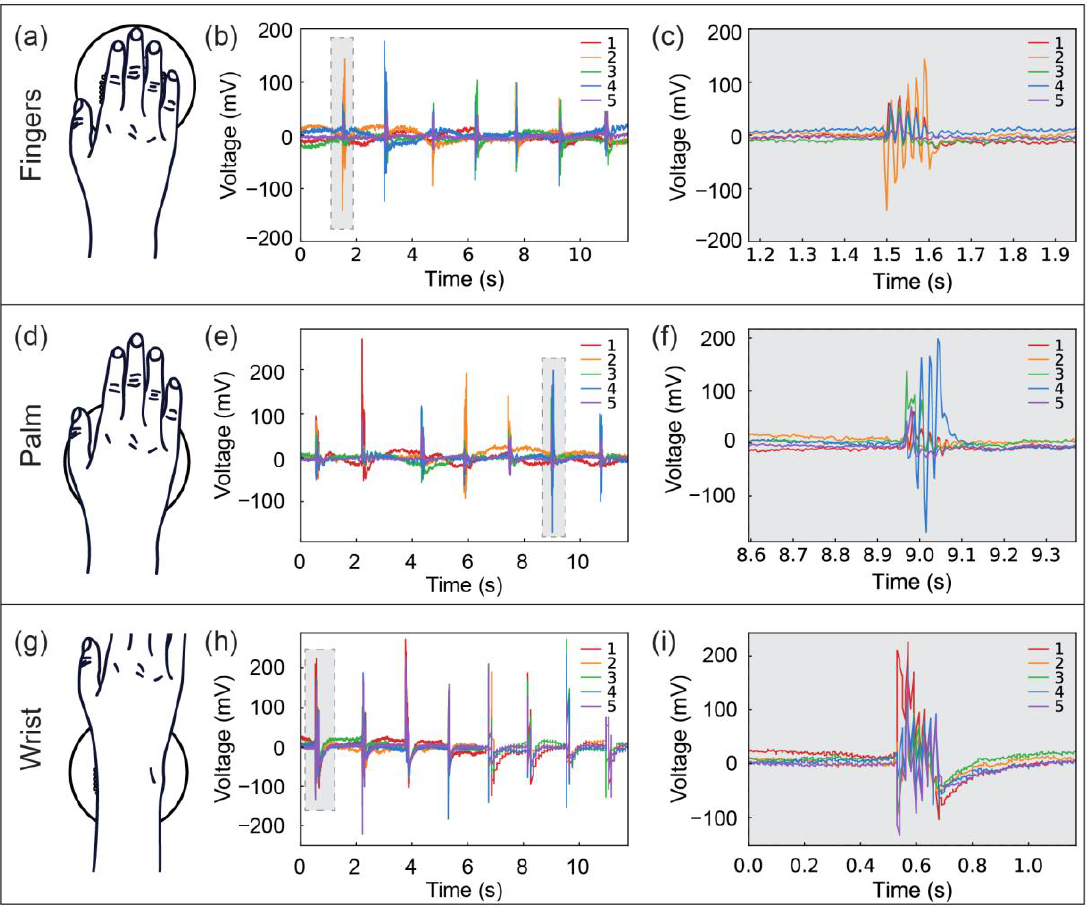
Figure 6. The signal of different types of touch. ( a ) Schematic diagram, ( b ) piezoelectric signal and ( c ) partially enlarged diagram of fingers part contacting with the sensor array. ( d ) Schematic diagram, ( e ) piezoelectric signal and ( f ) partially enlarged diagram of palm part contacting with the sensor array. ( g ) Schematic diagram, ( h ) piezoelectric signal and ( i ) partially enlarged diagram of wrist part contacting with the sensor array.